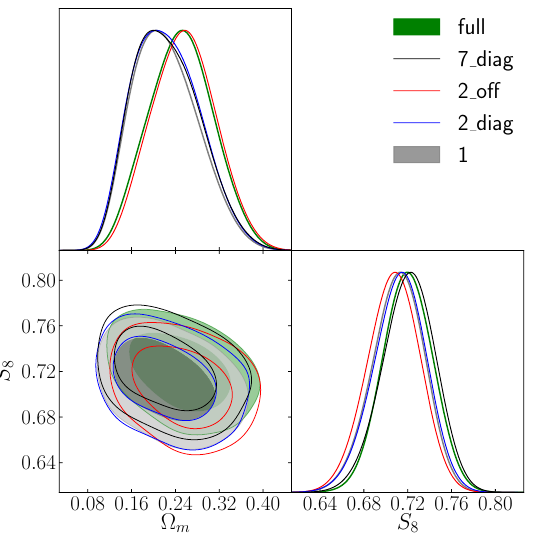
Figure 12. Marginalized posterior distribution for the parameters Ω m and S 8 . These contours are obtained with a Fourier-space anal- ysis assuming a scale-dependent KL transform. Different colours represent different levels of KL compression: full is the full analy- sis with no KL-compression, n off is the KL-compression where we consider n radial modes and the cross-correlations between them, in n diag we consider n radial modes without the cross-correlations, 1 shows the maximum compression we can achieve by considering only 1 mode.